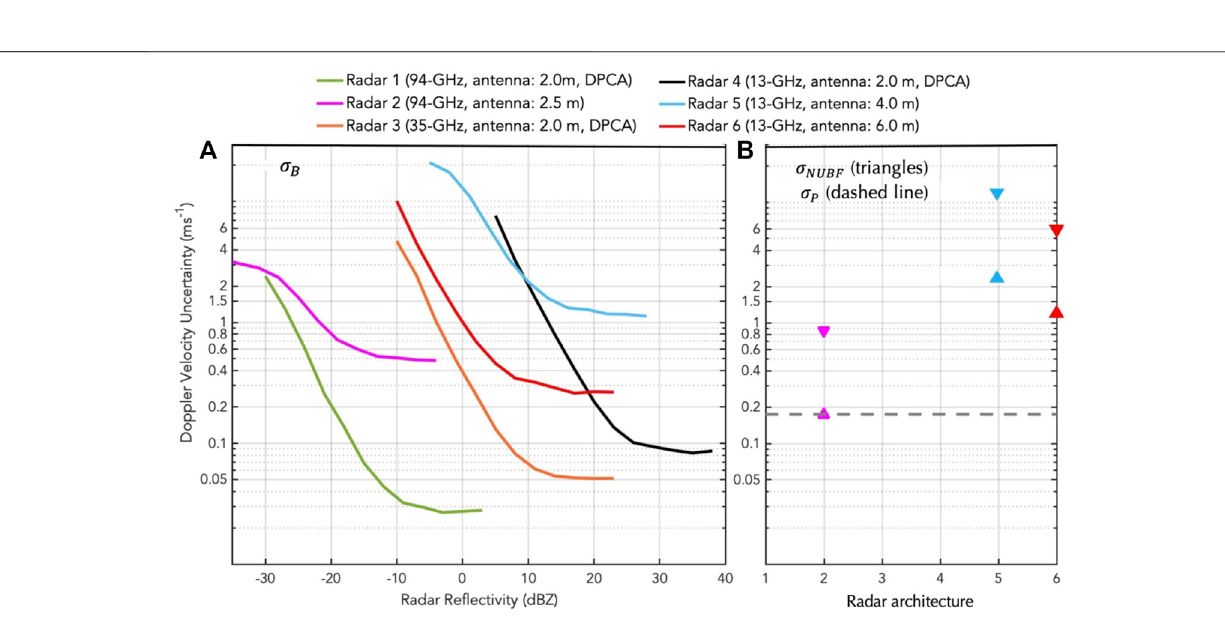
Frontiers in Remote Sensing |